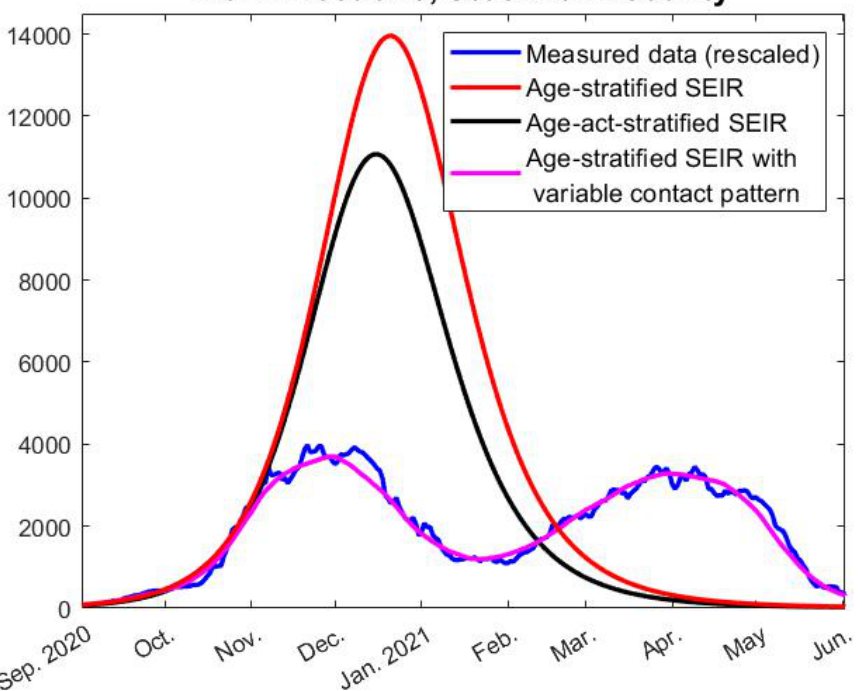
Figure 3. Comparison between real data and model outcome for the age-stratified SEIR and age- activity-stratified SEIR based on [5], which assumes that contact patterns are stable over time. The pink graph is produced with variable social interactions (over time), as described further in Section